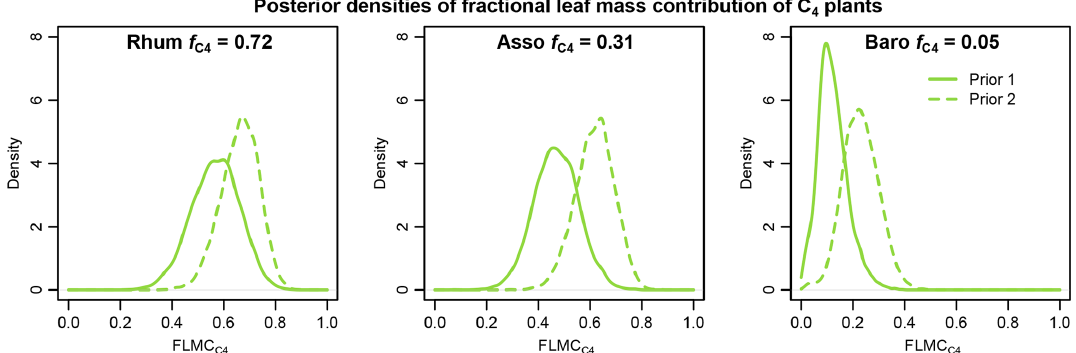
) based on two sets of prior 4